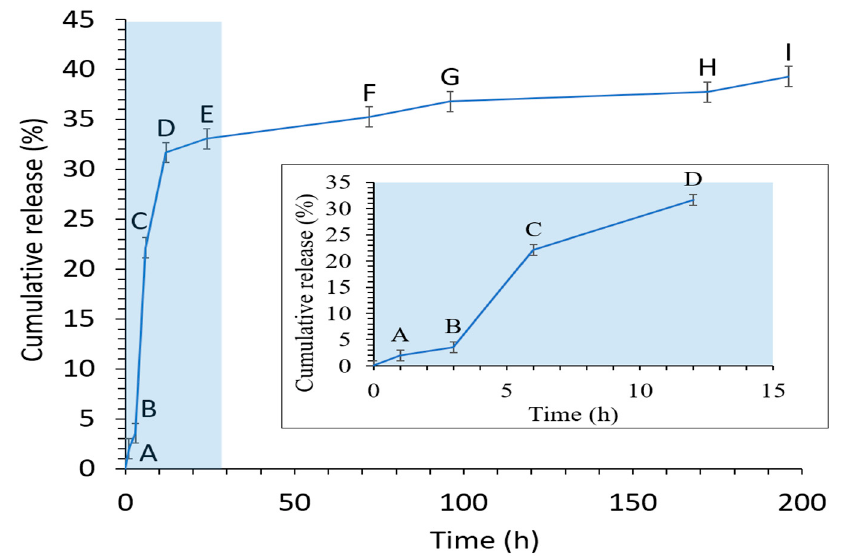
Figure 7. In vitro CRISPR pDNA cumulative release from CRISPR ALG NPs (mean ± SD; n = 3) in phosphate buffered saline (PBS) (pH 7.4). The inserted image represents detail of release during the first 12 h.